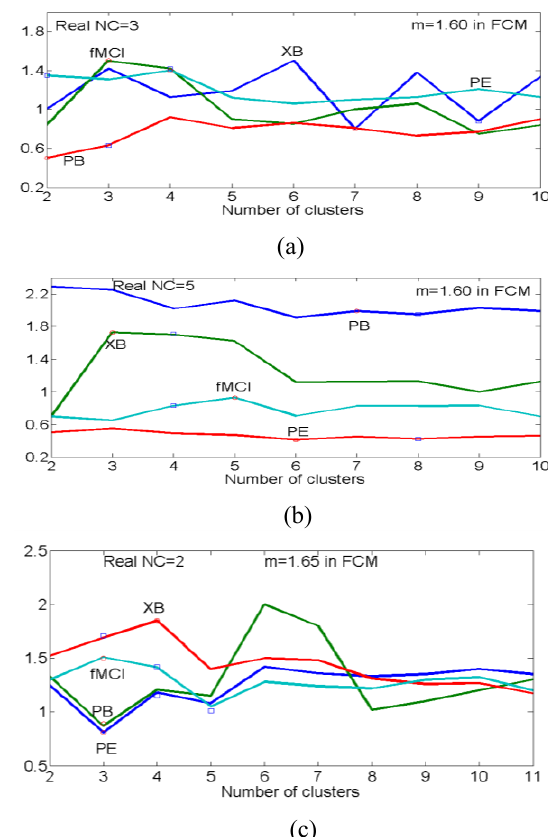
Fig.3 . Comparison of fMCI and the three fuzzy indices PB, XB, and PE in dataset 1-3 that responds to (a)-(c), where the circle symbol “○” stands for the optimal value of any validity index, and the square symbol “□” for the second optimal value, the difference between these two symbols represent the robustness of the fMCI.